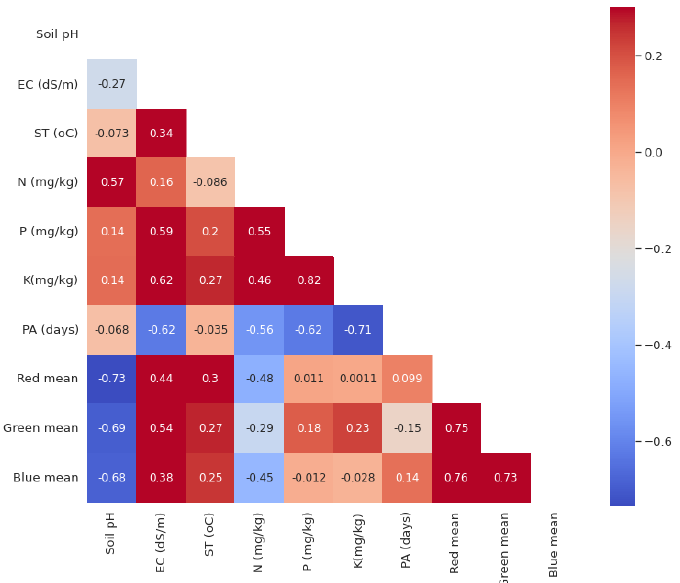
Figure 6. Association heatmap of soil physicochemical parameters and R , G , and B mean values.